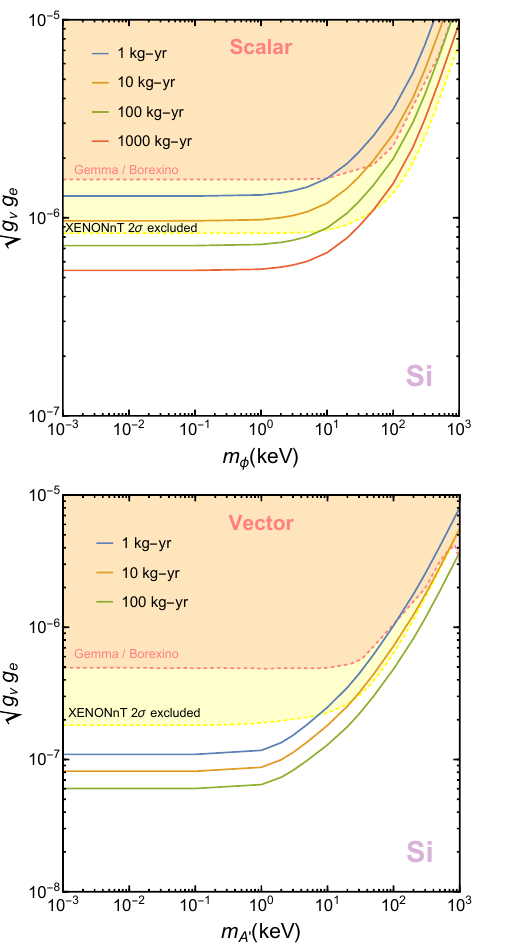
√ Figure 5 . Projected bounds on the coupling g ν g e at 90% confidence level as a function of the mediator masses. The bounds are given for four different exposure values: 1 kg-yr, 10 kg-yr, 100 kg-yr, and 1000 kg-yr for scalar mediators (top panel) for silicon (left) and germanium (right) target. For the vector mediator (bottom panel) three different exposure have been considered: 1 kg-yr, 10 kg-yr, and 100 kg-yr. The current excluded regions from XENONnT (yellow region) and Gemma/Borexino (orange region) are also shown. We have assumed a constant background of 0.1 DRU and the detector threshold is 5